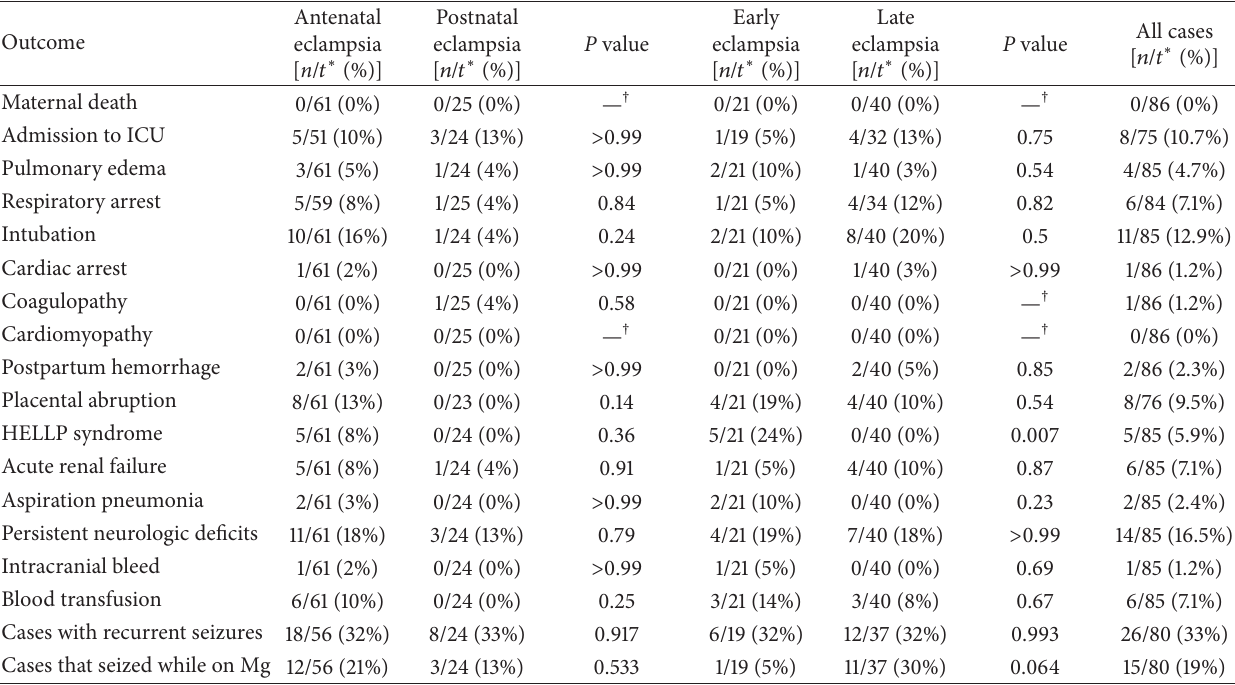
Table 2: Maternal outcomes of eclampsia cases.